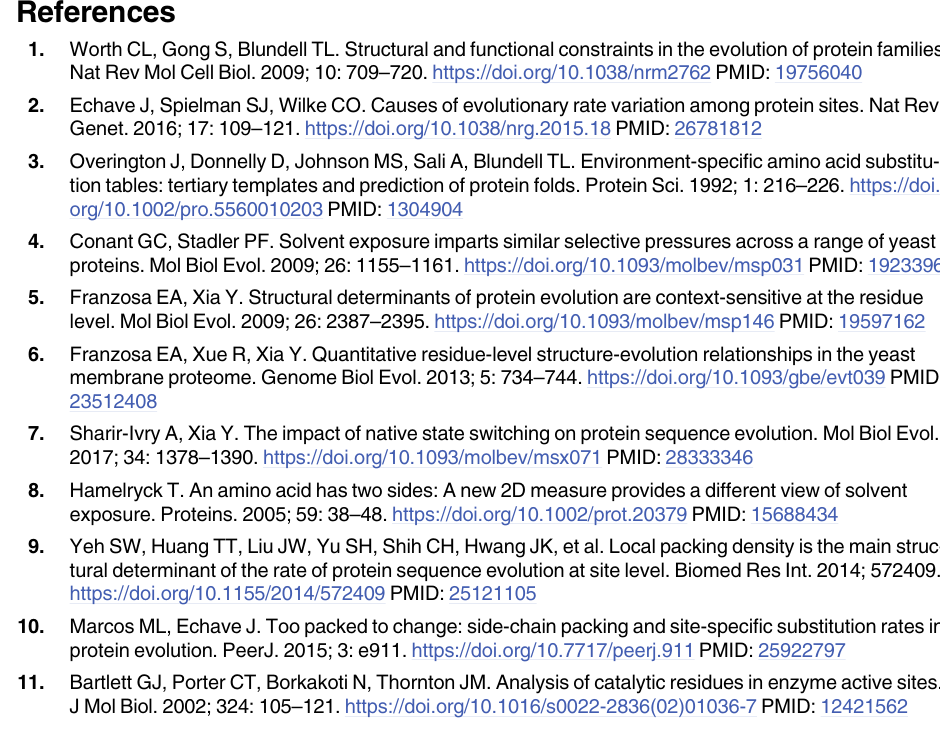
S2 Table. List of all yeast proteins, their structural models and identified functional sites. (XLSX) S1 Text. Conservation scores downloaded from ConSurf-DB for all the proteins participat- ing in this study. (RAR) S2 Text. Calculated conservation gradients for each residue in every protein in the dataset. The file also lists the conservation gradients calculated using Spearman correlation, calculated up to 30 Å away from the reference residue and calculated with the relative contribution of SC-WCN eliminated. (RAR) S3 Text. Codon alignments of protein coding genes of S. cerevisiae with its four closely- related yeast species ( S. paradoxus , S. mikatae , S. bayanus , and S. pombe